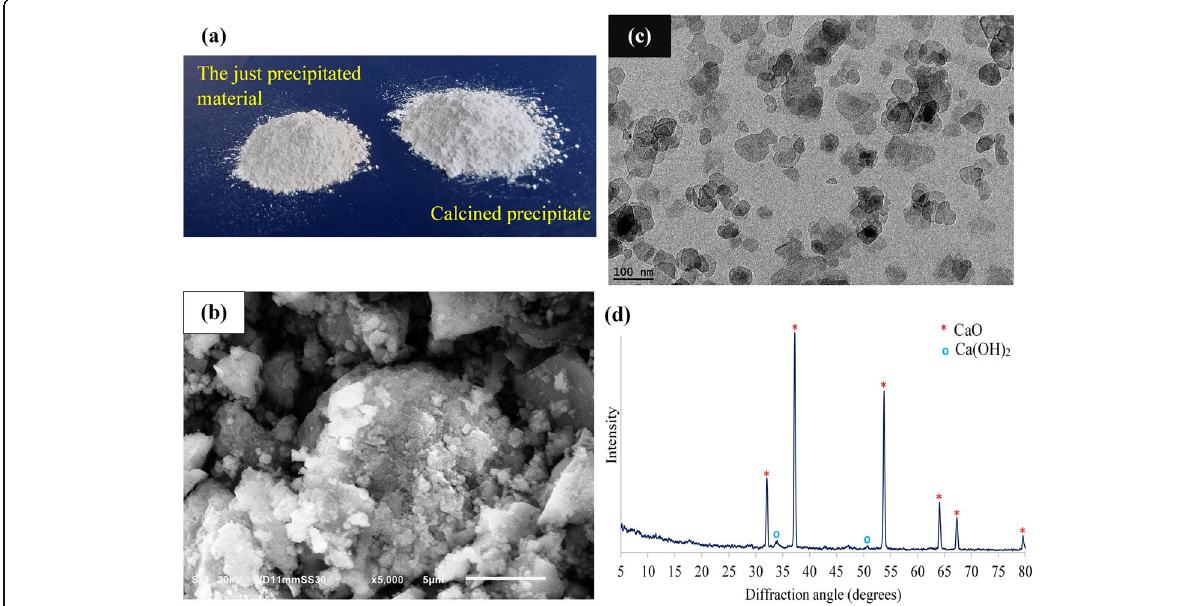
Fig. 4 Characteristic features of the snail shell-derived catalyst: a image of the just-precipitated material after crushing to powder (left) and the calcined precipitate or catalyst (taken by TECNO Pouvoir 3 Plus), b SEM image of the catalyst, c TEM image of the catalyst, and d XRD spectrum of the